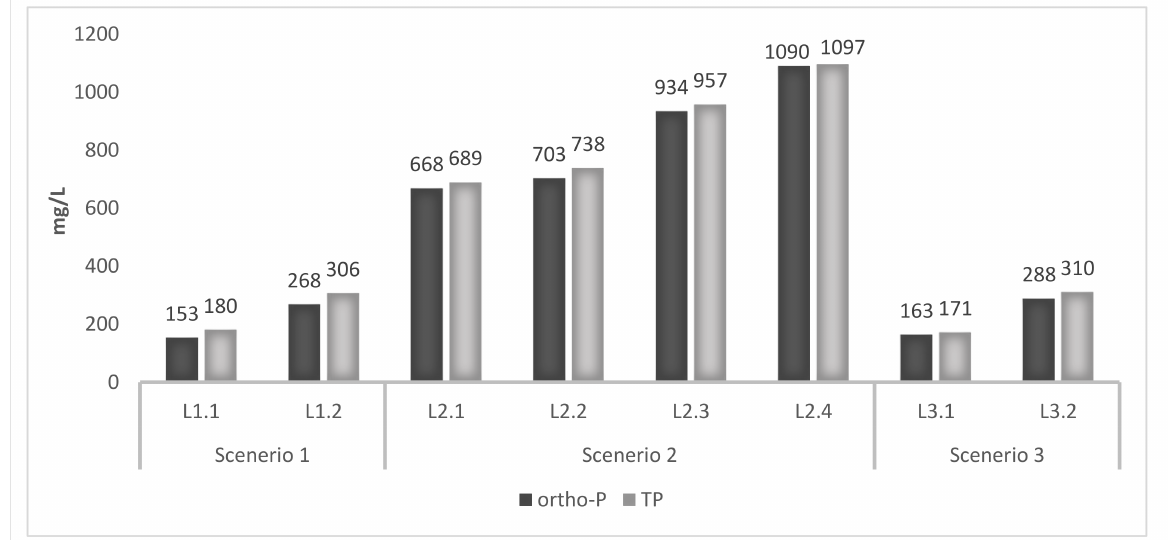
Figure 2. Concentration of TP and ortho-P in the leachate after solid–liquid separation. In the leachate L1.2, L2.3, L2.4, and L3.2, despite using the same amount of acid, the highest TP transformation into the leachate was observed in L2.3 (957 mg/L) and L2.4 (1097 mg/L), which was >300% higher in comparison with L1.2 at 306 mg/L and